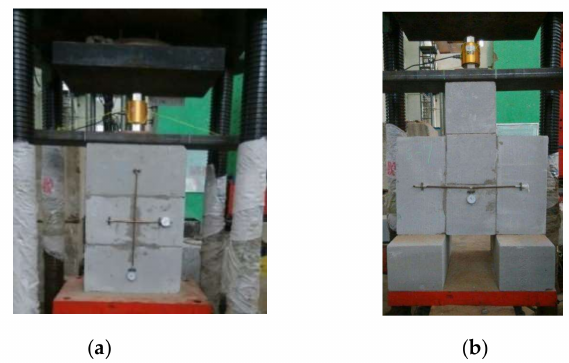
Figure 1. Tests of block masonry: ( a ) compression; ( b ) shear along mortar